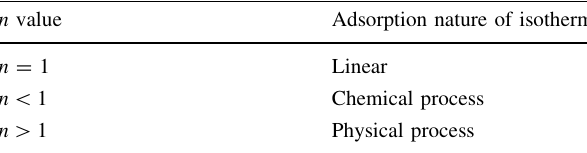
Fig. 7 Freundlich isotherm indicating the variation of log q e with respect to log C e for adsorption of As(III) Table 8 Effect of n values on Freundlich isotherm